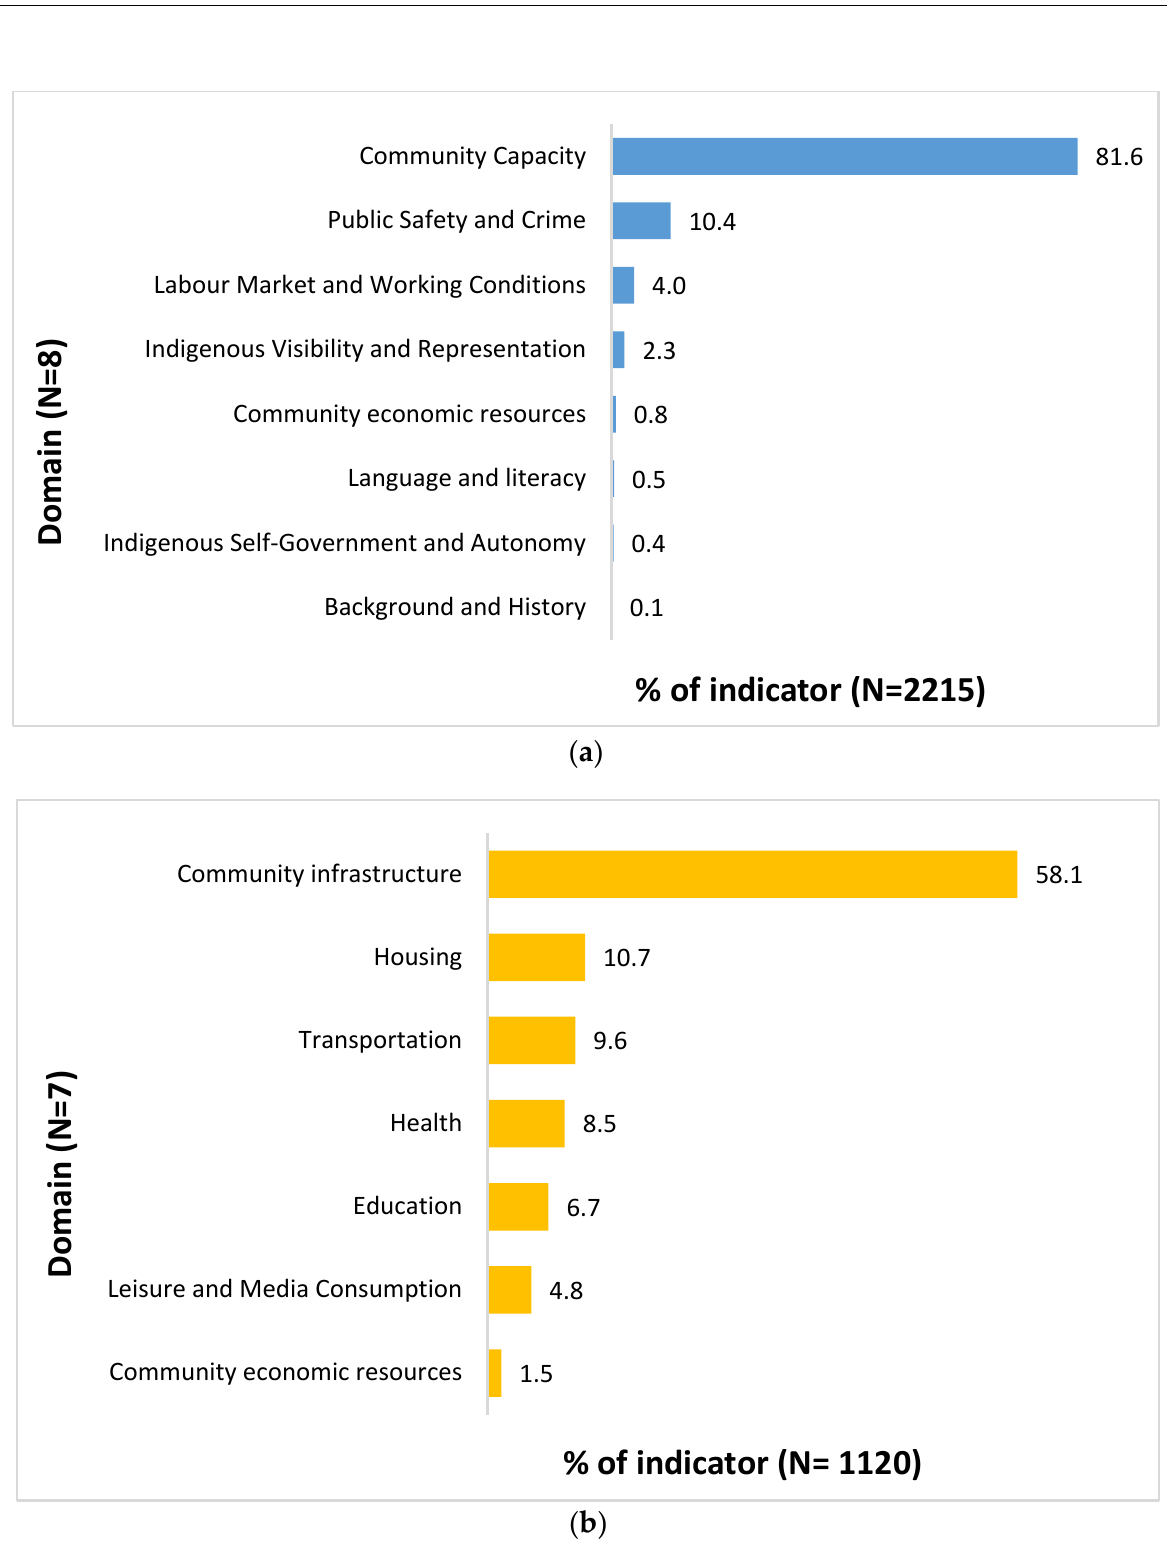
Figure 2. ( a ) Distribution of indicators by domain for the socio-political environmental subject group; ( b ) distribution of indicators by domain for the built environmental subject group.